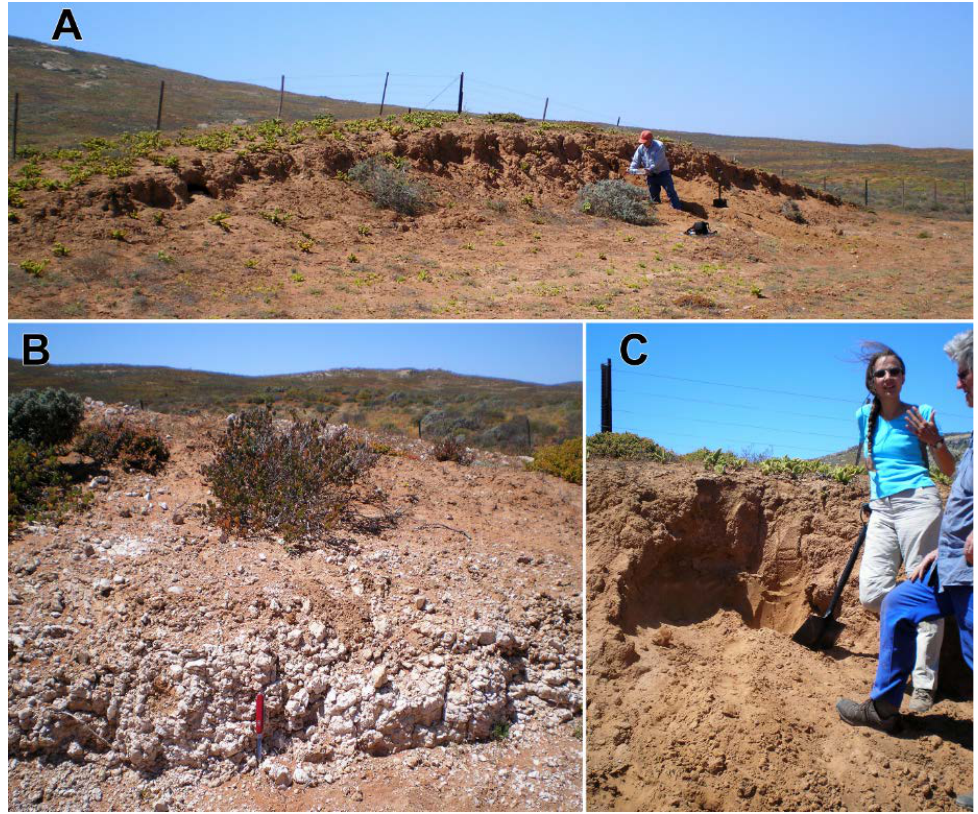
Figure 3. ( A ) A large heuweltjie and co-author M.T. Hoffman 7 km southwest of Soebatsfontein, Northern Cape bisected by road excavation work ( −30.17718° S, 17.55423° E). This is the “Soebatsfontein 2” mound described in McAuliffe et al. [19]. This entire area has been heavily used by livestock for decades and the relatively barren surface of the mound can be attributed to such use; ( B ) Cemented pedogenic carbonate layer approximately 50 cm below the surface of another heuweltjie near Soebatsfontein. The red pocket knife handle, positioned vertically in the centre foreground, is 9 cm long; ( C ) Heuweljtie researcher Natalie Kunz and co-author M.T. Hoffman at an excavation in the Soebatsfontein 2 heuweltjie (Figure 3A), showing the deep, relatively non-cohesive, fine sandy loam with little pedogenic modification. The depth of this more recently accumulated sediment was 138 cm.